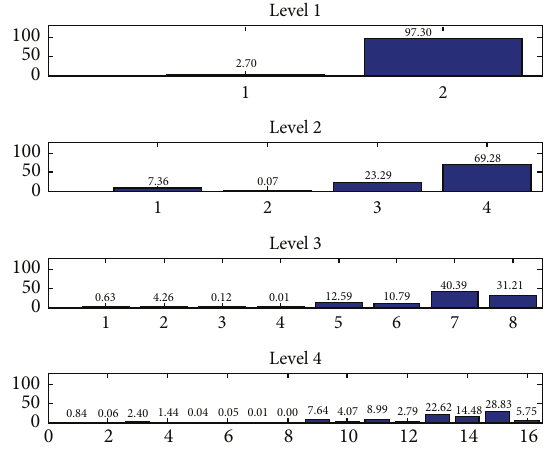
Figure 6: Energy distribution of four-level subbands.